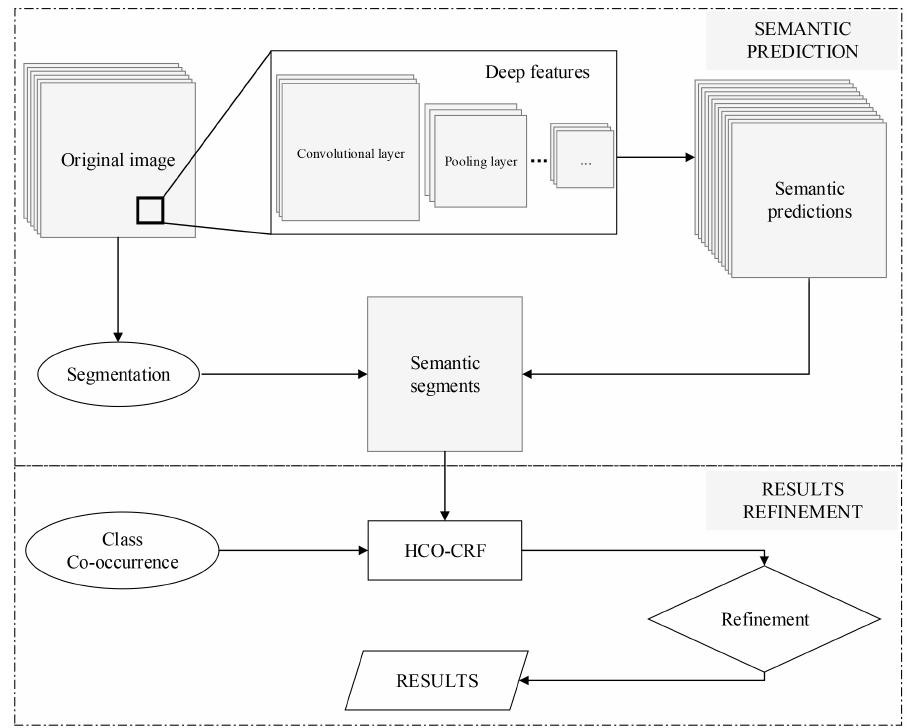
Figure 1. The flowchart of dense semantic labeling with higher-order co-occurrence graph